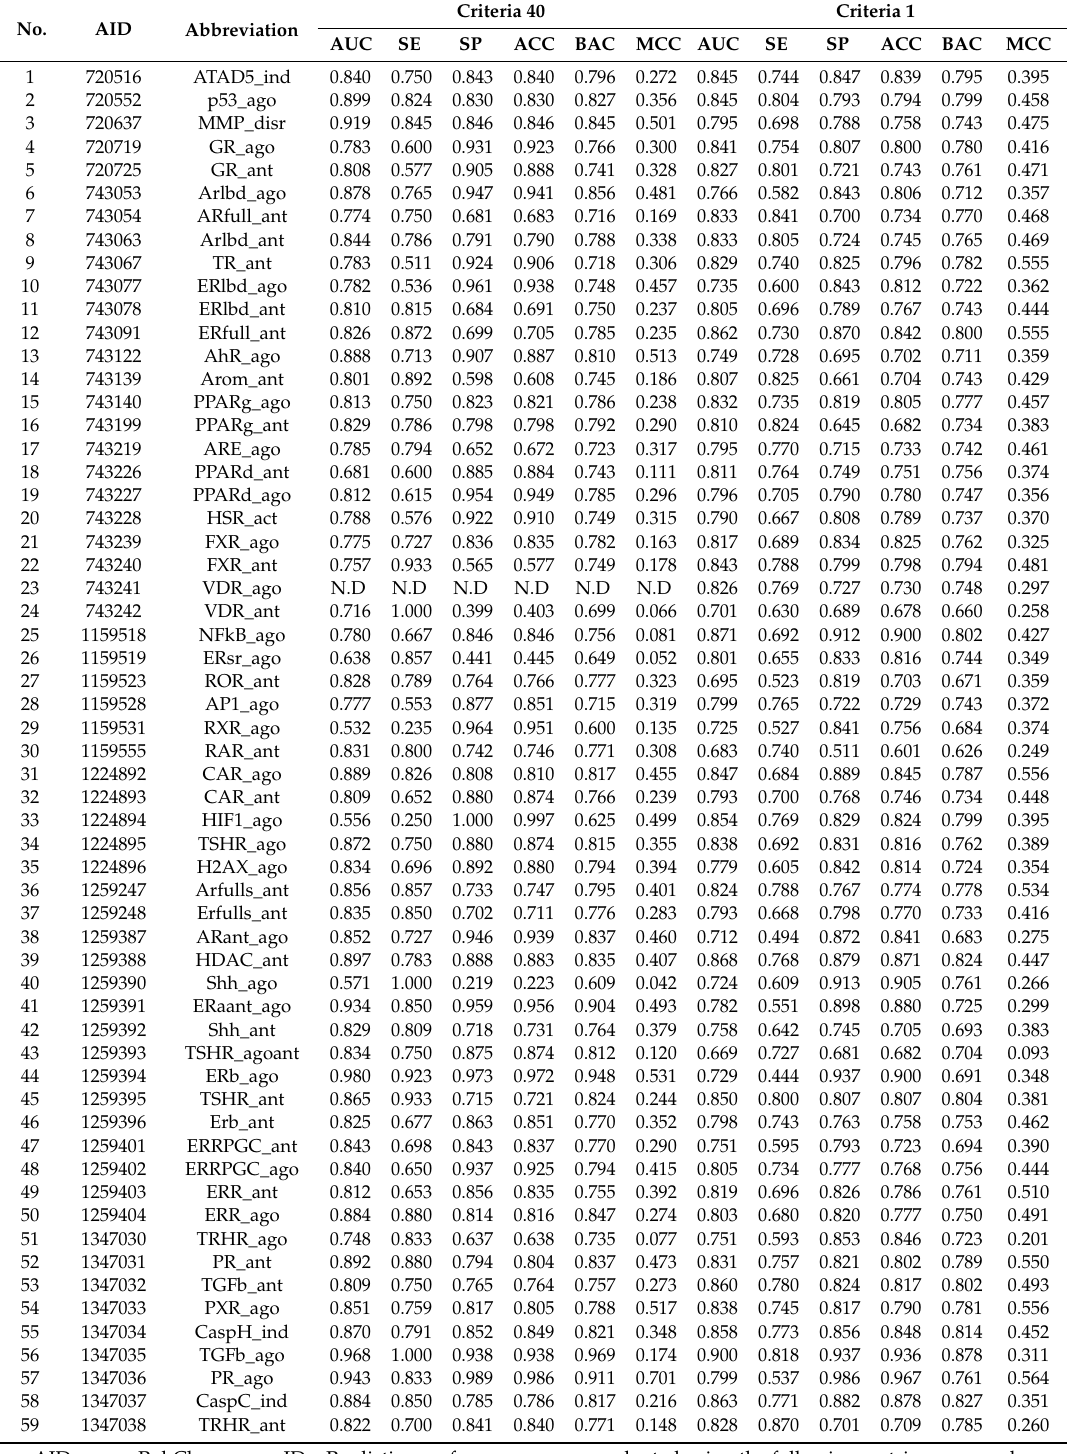
Table 1. Predictive performances in the test set for each